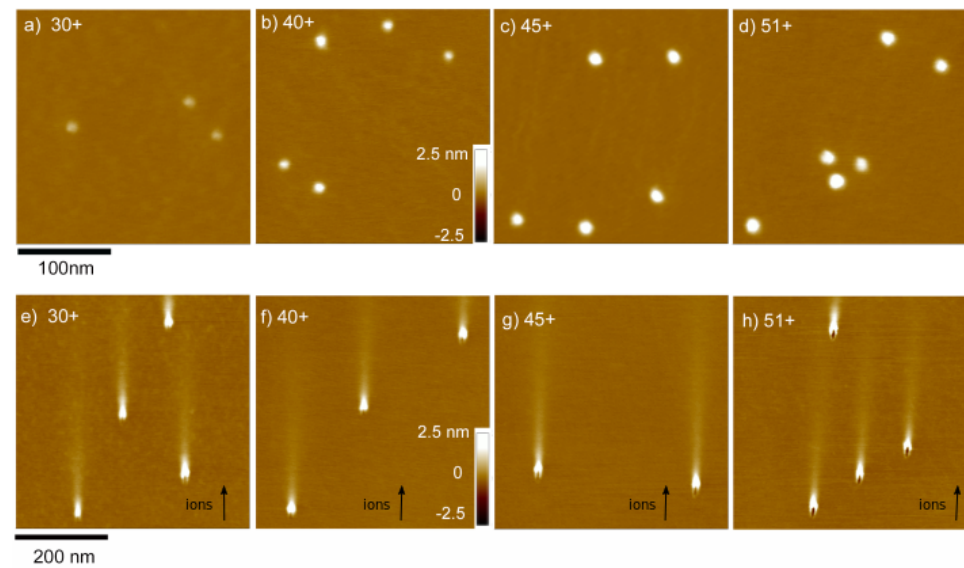
Figure 3. SFM images of mica crystals bombarded at two different angles of incidence by 3 MeV/u Au q + of different initial charge states. Images ( a – d ) depict impacts at normal incidence and images ( e – h ) are of samples bombarded at grazing incidence (11 ◦ to the surface). The entrance charge state is given in each panel. The color (height) scale is the same for all images. The scale bar of 100 nm applies to images ( a – d ), and the bar of 200 nm to images ( e – h ). Black arrows indicate the direction of the ion beam for grazing